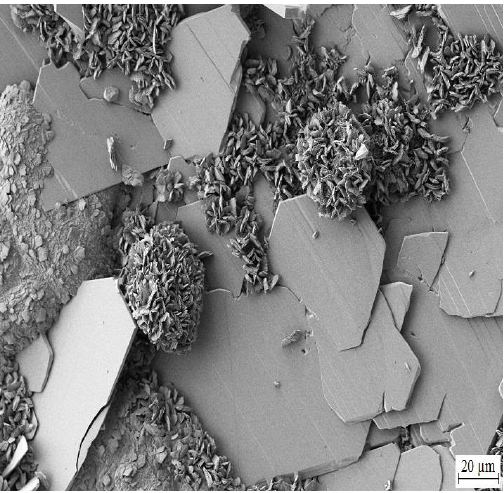
Figure 15. Detail view of corrosion products shown in Figure